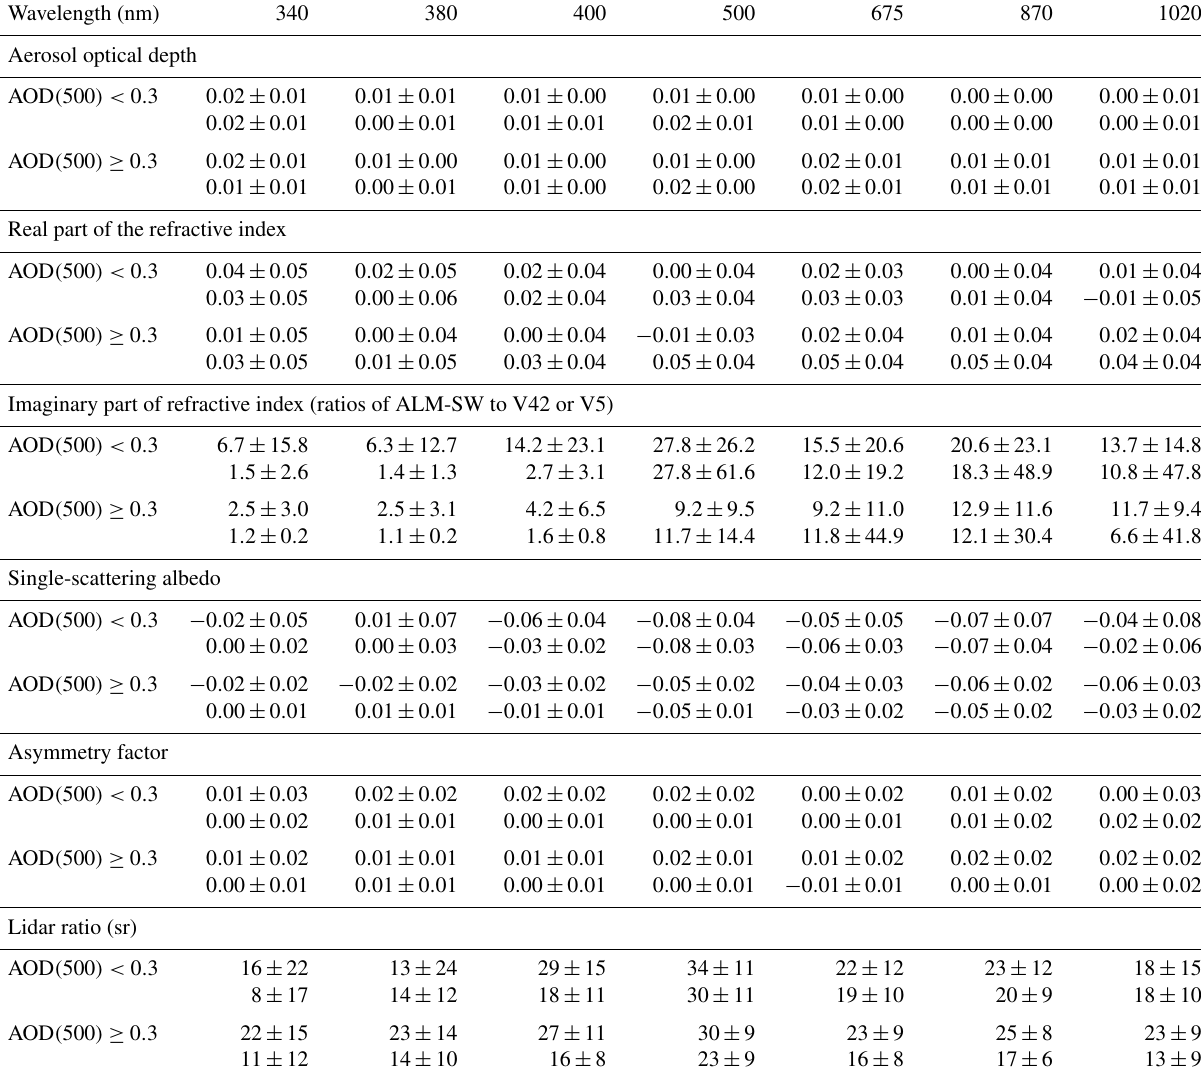
Table 6. Means and standard deviations of the differences between the ALM-SW retrievals and the V42 (upper) and V5 (lower) retrievals. Wavelength (nm) 340 Aerosol optical depth